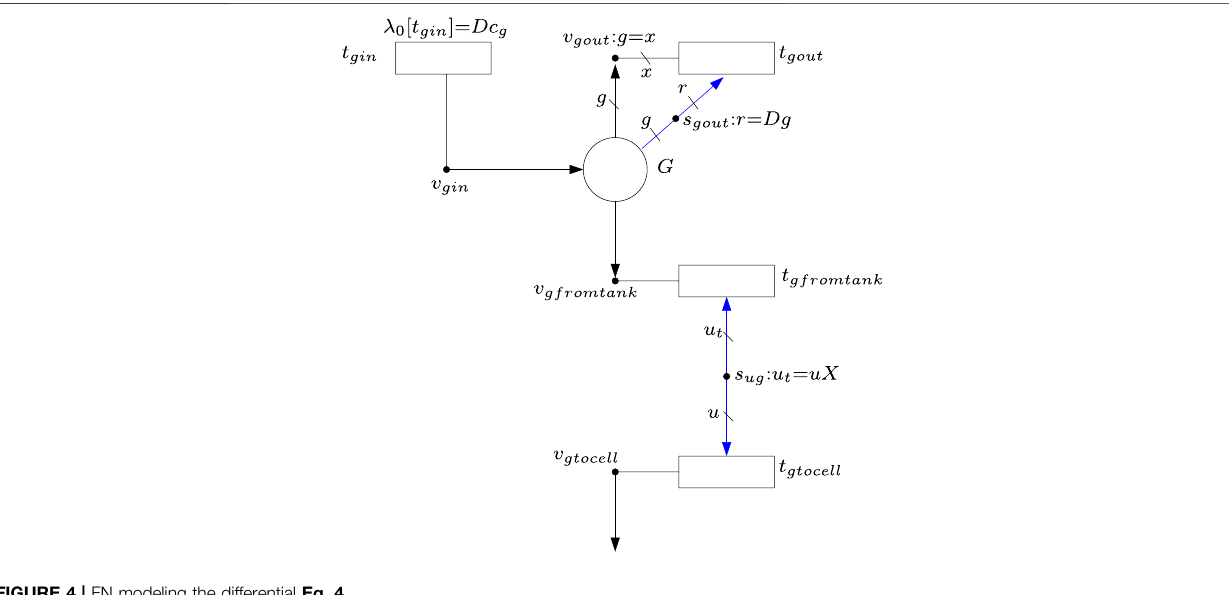
FIGURE 4 | FN modeling the differential Eq.